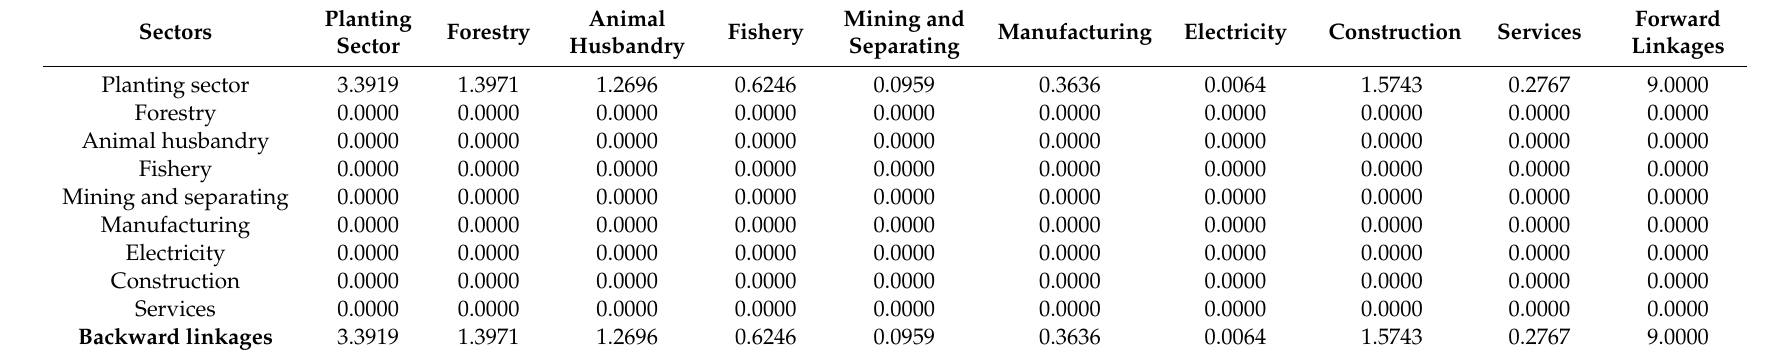
Table A3. Normalized matrix of backward and forward reallocation linkages for green water in economic sectors.